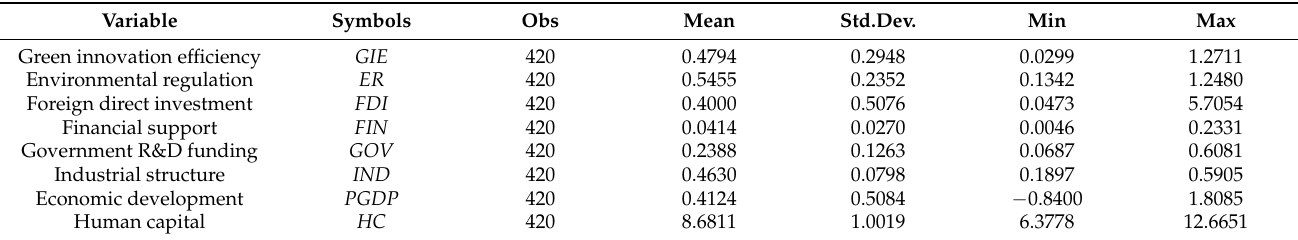
Table 1. Statistical description of variables.